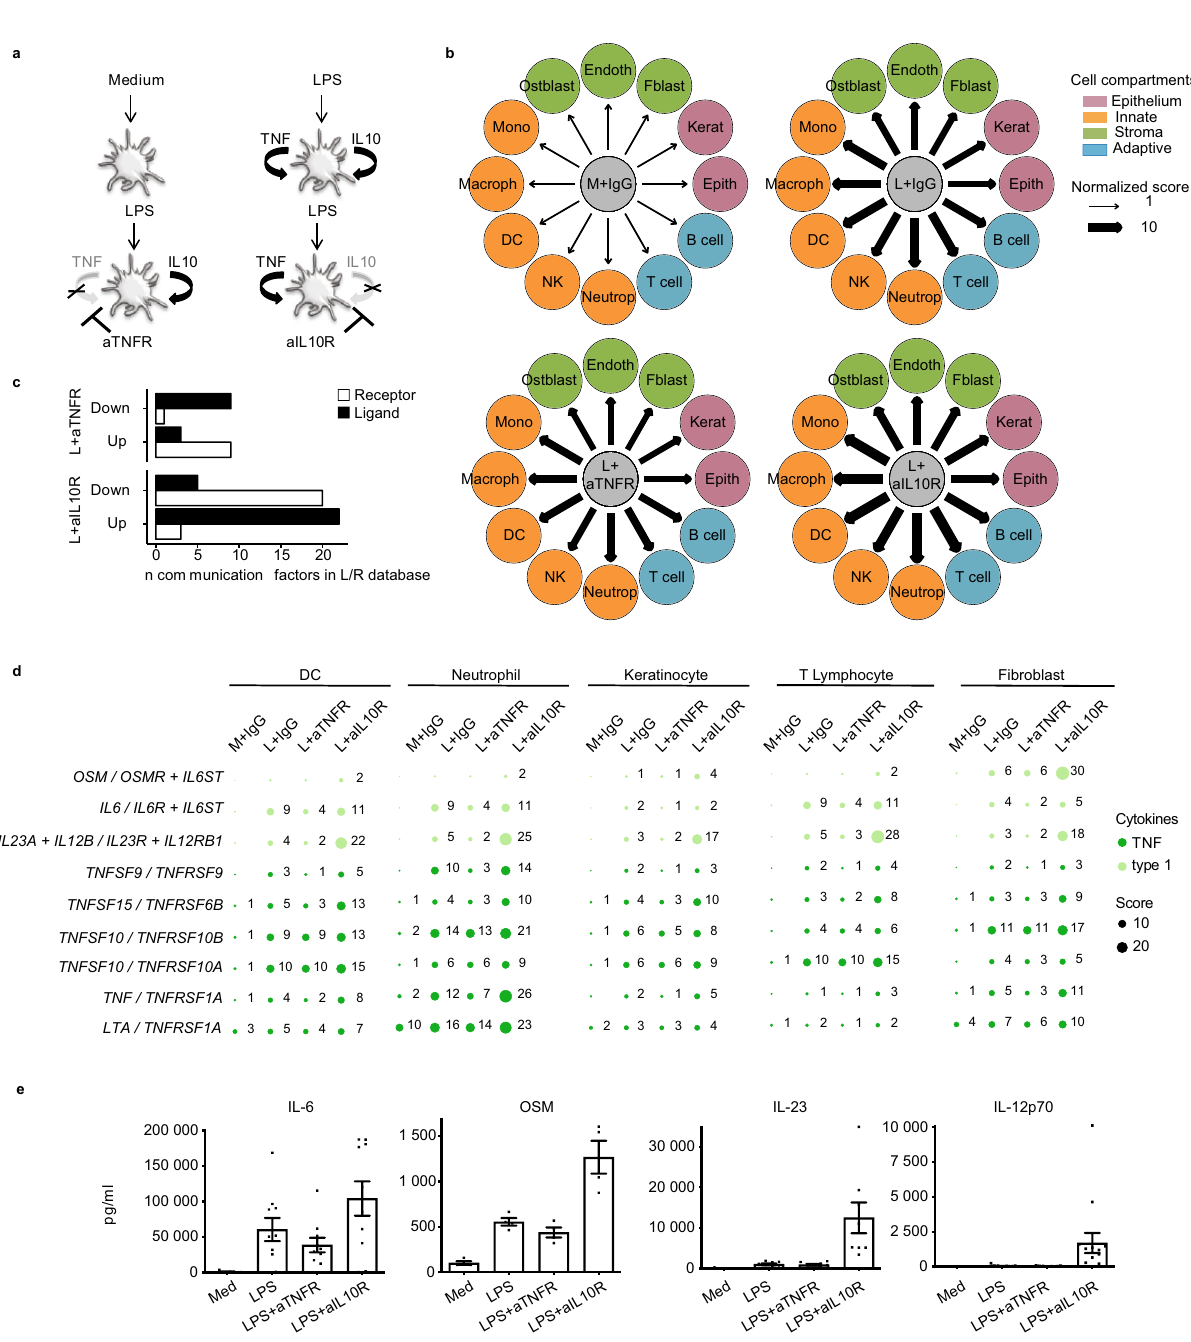
Fig. 5 IL-10R blocking activates a cell-to-cell communication module in LPS-stimulated DCs. a Depicted are the four experimental conditions for which transcriptomics was generated ( n = 6 biologically independent samples). b Connectivity maps describing outward communication from DCs to putative target cells in the conditions: Medium (M), LPS (L), LPS + aTNFR and LPS + aIL-10R. Twelve primary cell types are considered as partner cells (DC: conventional dendritic cell, Macroph: macrophage, Mono: monocyte, Ostblast: osteoblast, Endoth: endothelial cell, Fblast: fi broblast, Kerat: keratinocyte, Epith: epithelial cell, B cell, T cell, Neutrop: neutrophil and NK: natural killer cell) and are colored depending on the cell compartment (green: stroma, orange: innate, blue: adaptive, pink: epithelium). The width of the edges corresponds to a global score combining the intensity of all the individual ligand/ receptor interactions, normalized to the medium condition. A scale ranging from 1 to 10, corresponding to minimum and maximum communication scores, is shown in the legend. c Gene corresponding to ligands (black) and receptors (white) counted in each loop signature (from n = 6 biologically independent samples for each conditions) and plotted according to regulation directionality: upregulated (Up) or downregulated (Down). Genes with separability score ≥ 4 were included in each condition ’ s signature. d Balloon plot representing a selection of individual interaction scores. e Protein levels of IL-6 ( n = 10 biologically independent samples, except for Medium condition where n = 5), OSM ( n = 4 biologically independent samples), IL-23 ( n = 8 biologically independent samples) and IL-12p70 ( n = 16 biologically independent samples, except for Medium condition where n = 8) demonstrating increased secretion in LPS + aIL-10R DC supernatant. Data are presented as mean values ± SEM. Some schematic art pieces were used and modi fi ed from